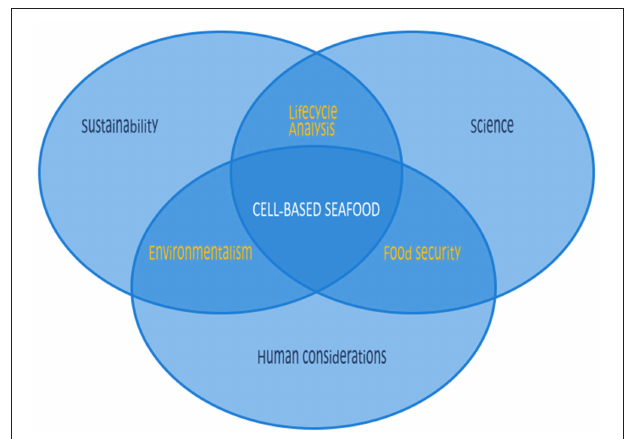
FIGURE 1 | Considerations for cell-based seafood are numerous, differing in many respects from those of cell-based land animals. While cell-based seafood shares some common ground with land-based analogs in science and human considerations, sustainability is a more substantial driver, as cell-based seafood could lead to greater preservation of marine